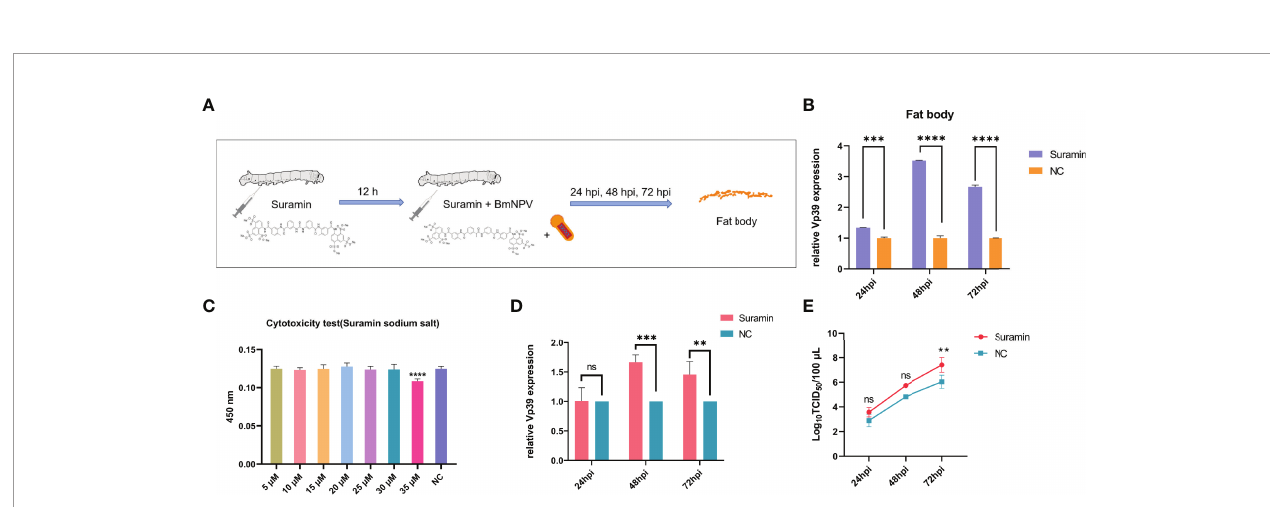
FIGURE 6 | The Sirt5 inhibitor, Suramin, promoted BmNPV replication. (A) Schematic diagram of treatment of silkworms with Suramin. (B) Quanti fi cation of the expression of the BmNPV capsid gene Vp39 by qRT-PCR after treatment with Suramin in the silkworm fat body at 24, 48 and 72 hpi. (C) Cytotoxicity assay of different concentrations of Suramin in BmN cells. (D) Quanti fi cation of Vp39 expression by qRT-PCR after treatment with Suramin in BmN cells at 24, 48 and 72 hpi. (E) Determination of viral titers using the TCID 50 assay. Each bar represents the mean ± SD. **p < 0.01, ***p < 0.001, ****p < 0.0001. ns, not signi fi cant.